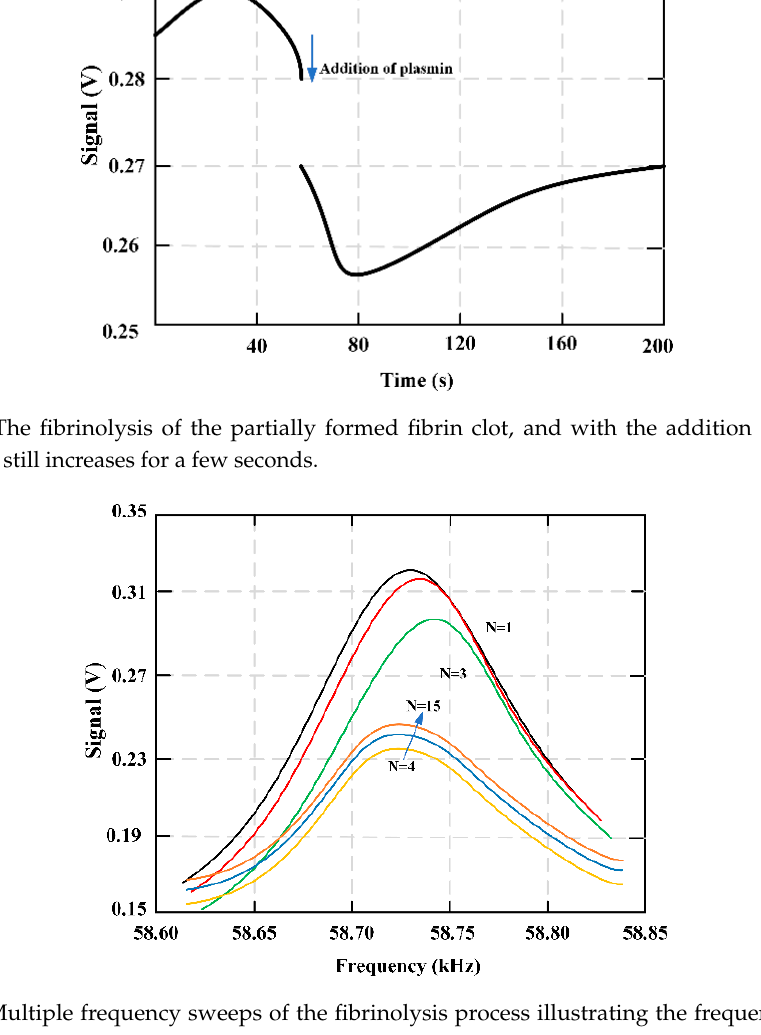
Figure 18. Multiple frequency sweeps of the fibrinolysis process illustrating the frequency change over time. Fifteen total scans were taken, with the addition of plasmin coming between the third and fourth